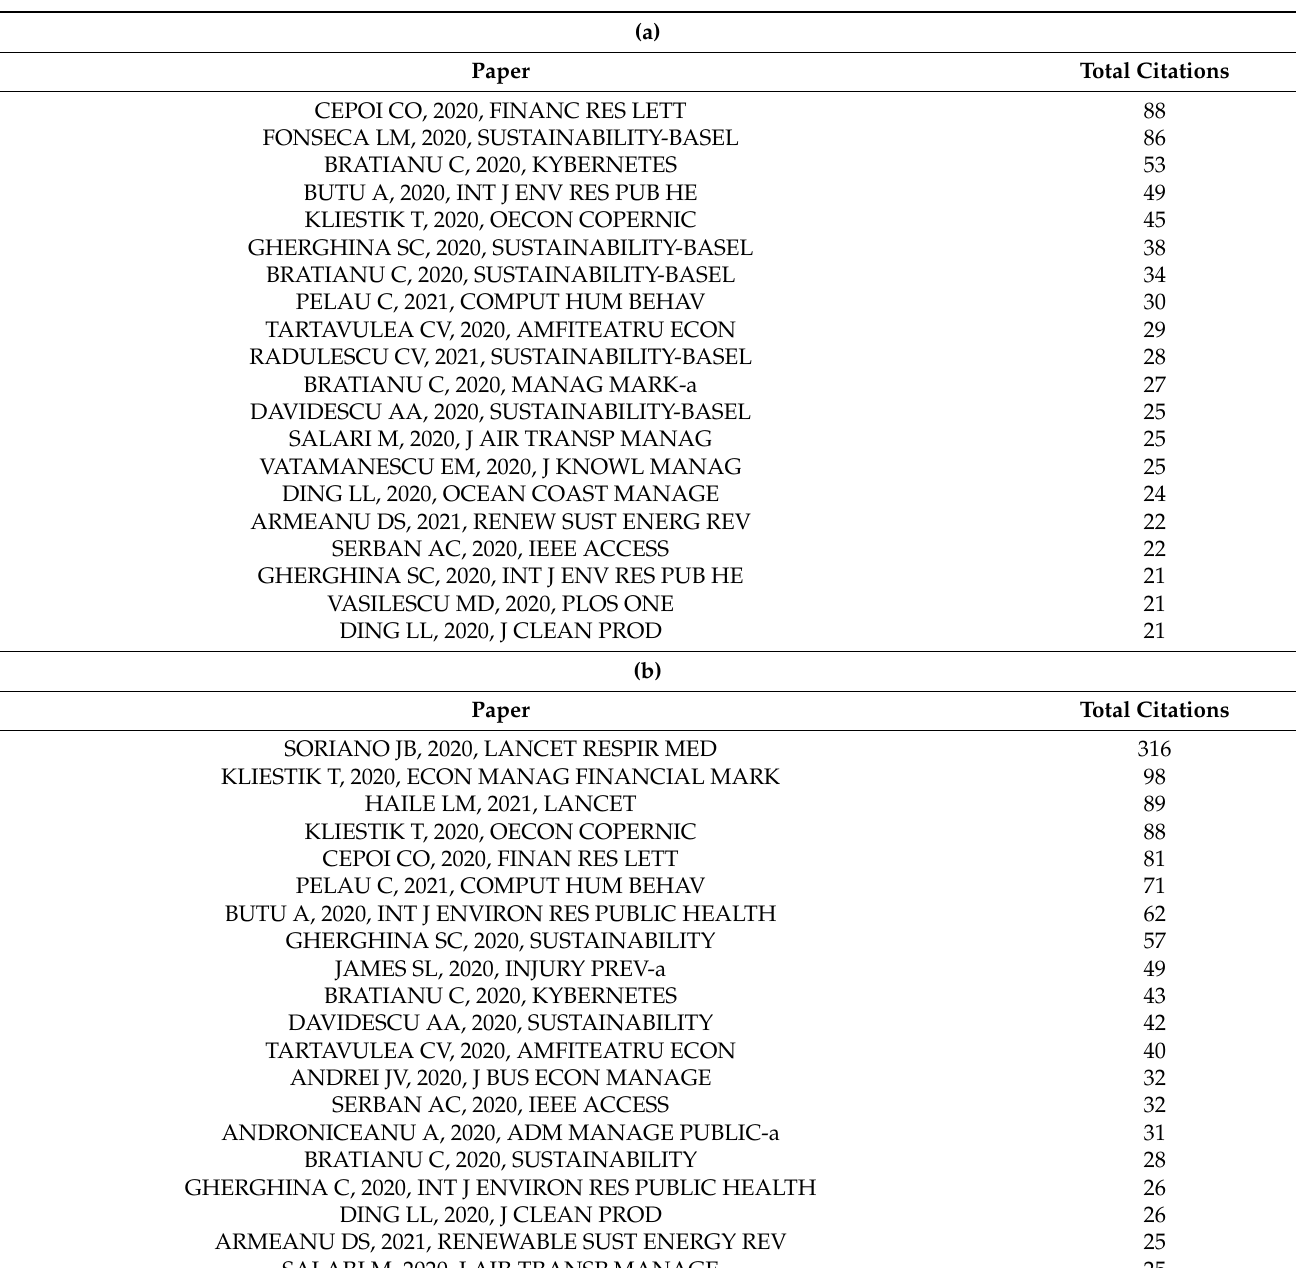
Table 4. Most important papers. ( a ) WoS. ( b )